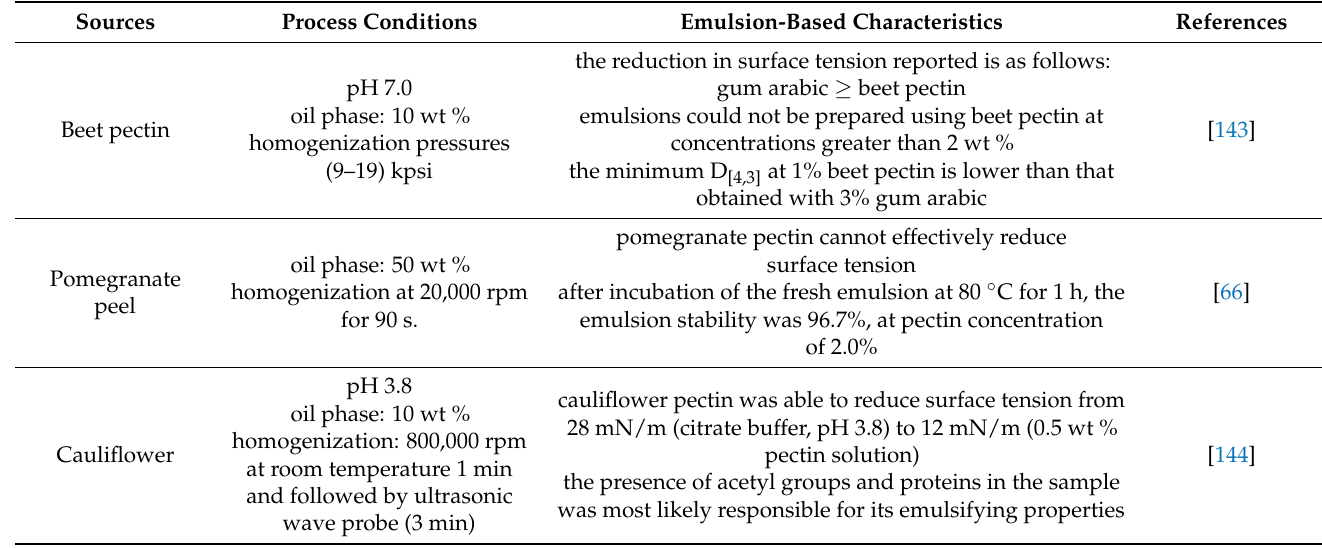
Table 4. Emulsifying and emulsion-stabilizing properties of pectins extracted from various